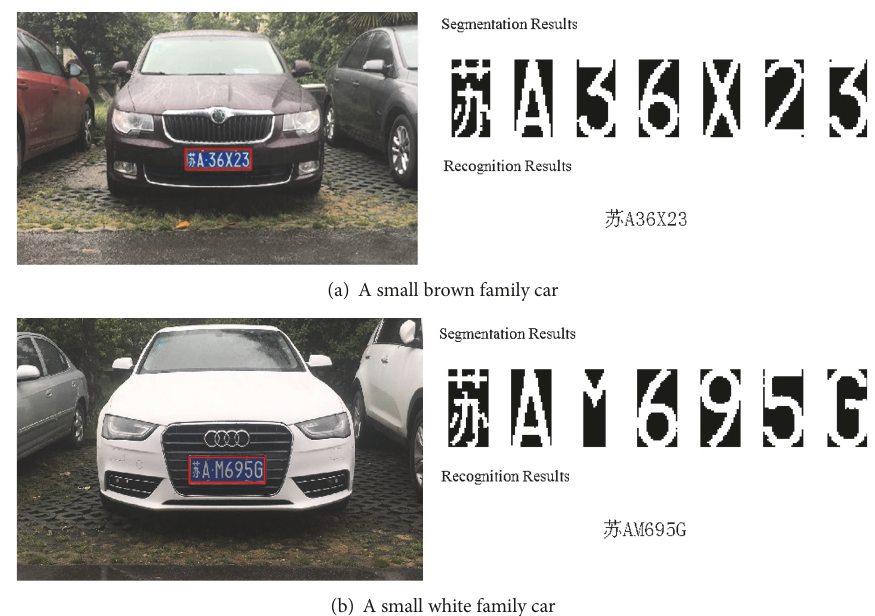
Figure 16: The license plate detection, segmentation, and recognition results.